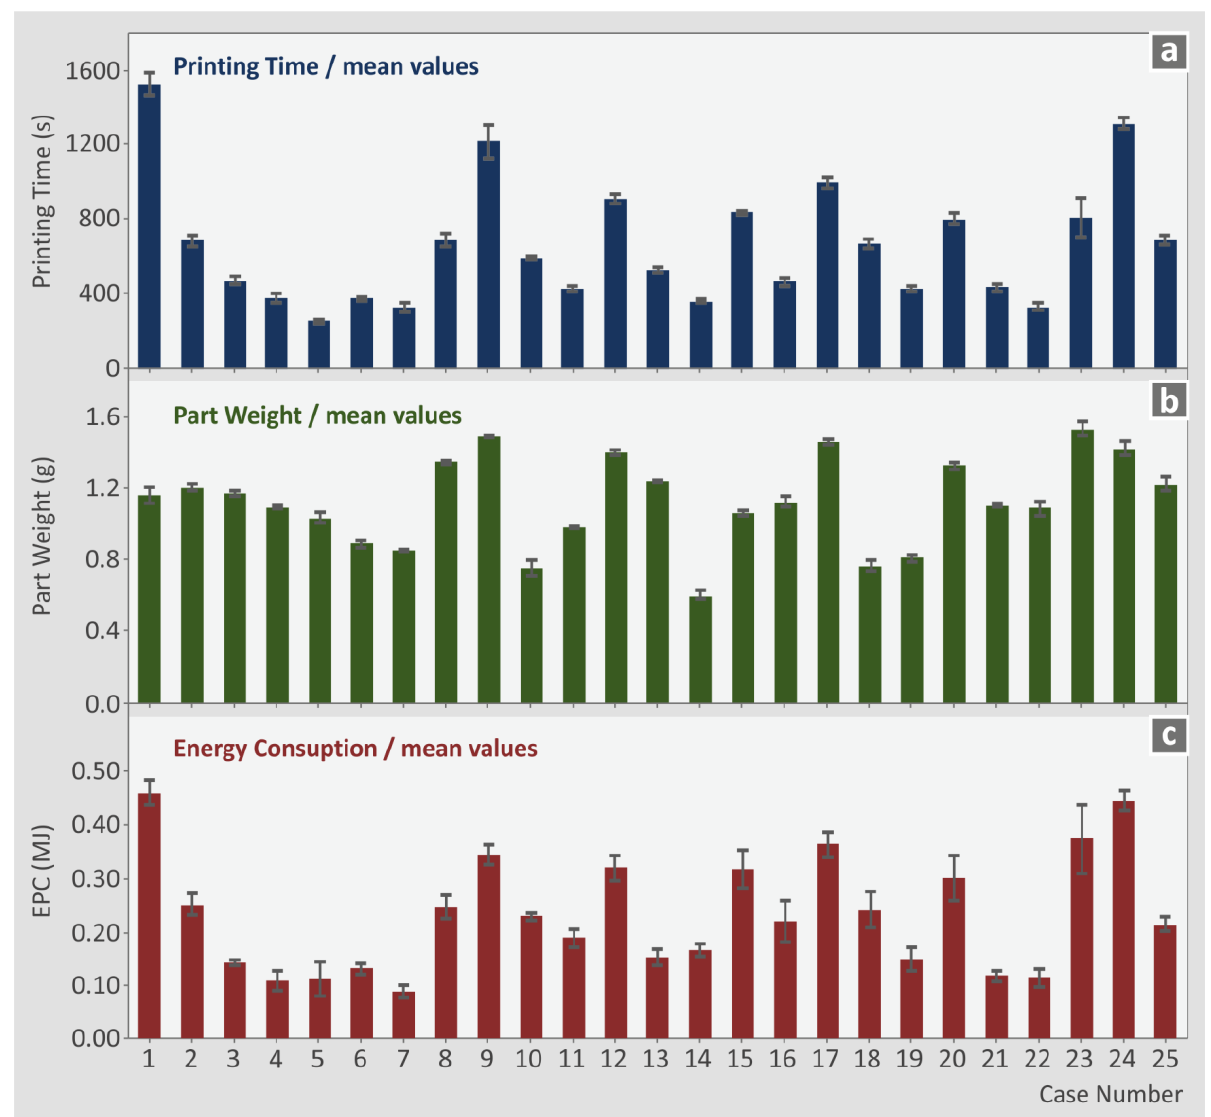
Figure 6. Average values and deviation of the experimental results for each one of the twenty-five runs: ( a ) printing time (s), ( b ) part weight (g), and ( c ) EPC (MJ).